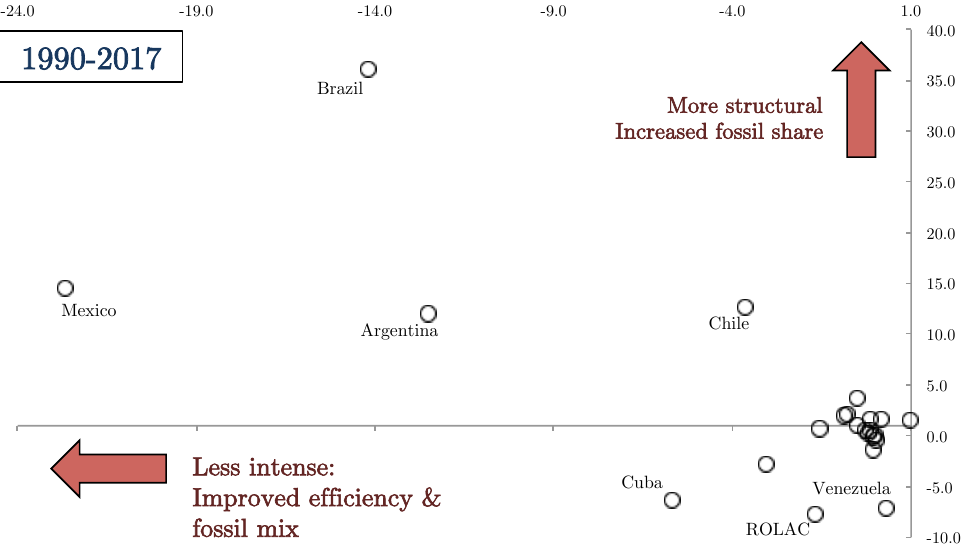
Figure 6. Structural and intensity effects by country, period